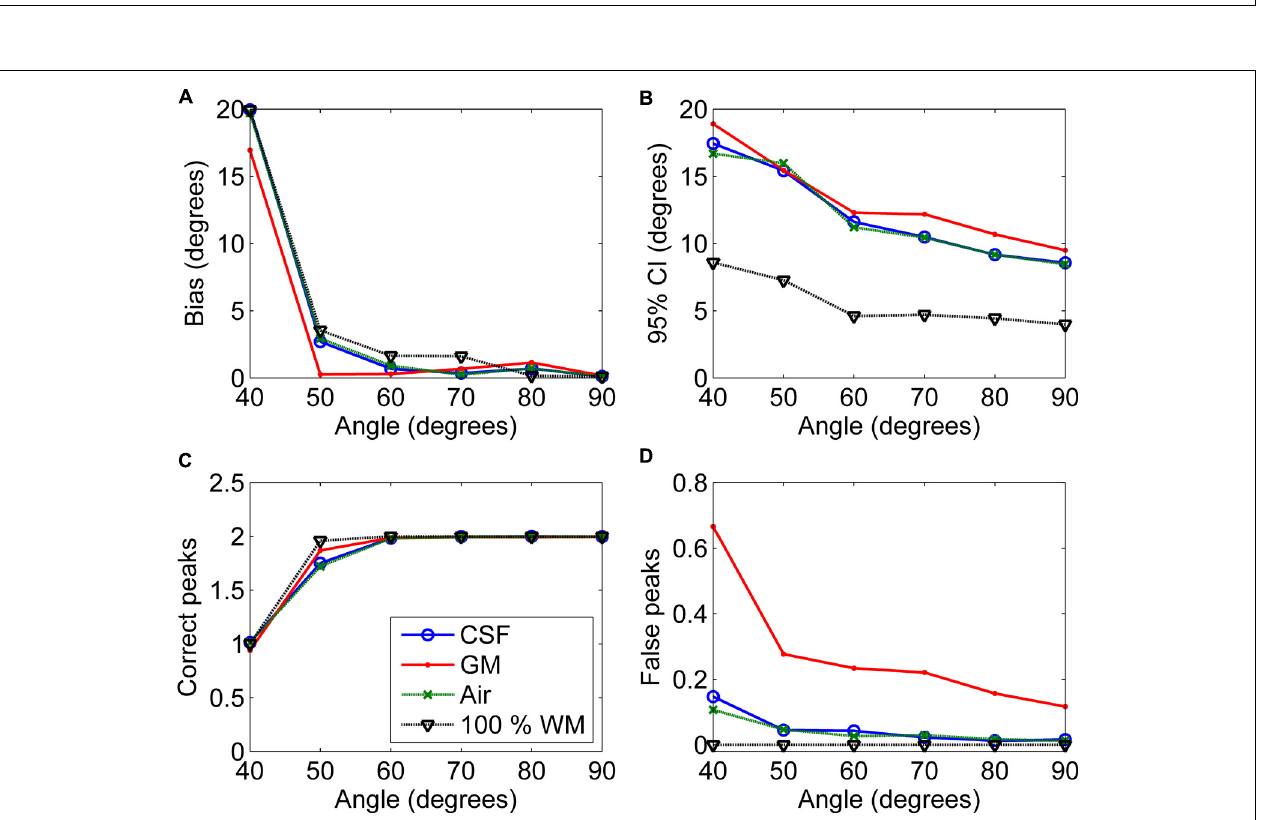
estimated with CSD (with up to eighth-order SH, angle 70 ◦ , and diffusion weighting 3000 s/mm 2 ). For comparison, 100% WM measures are provided.